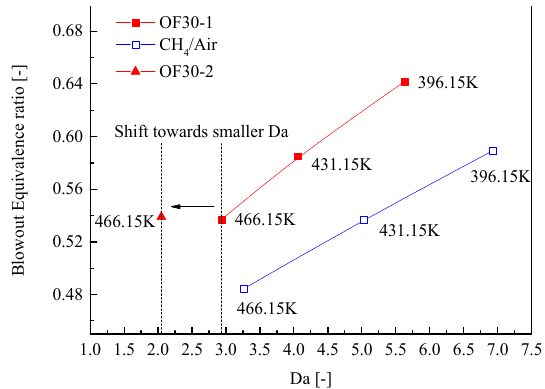
Figure 12. Dependence of experimentally measured lean blowout (LBO) limits on Da number and preheating temperature.